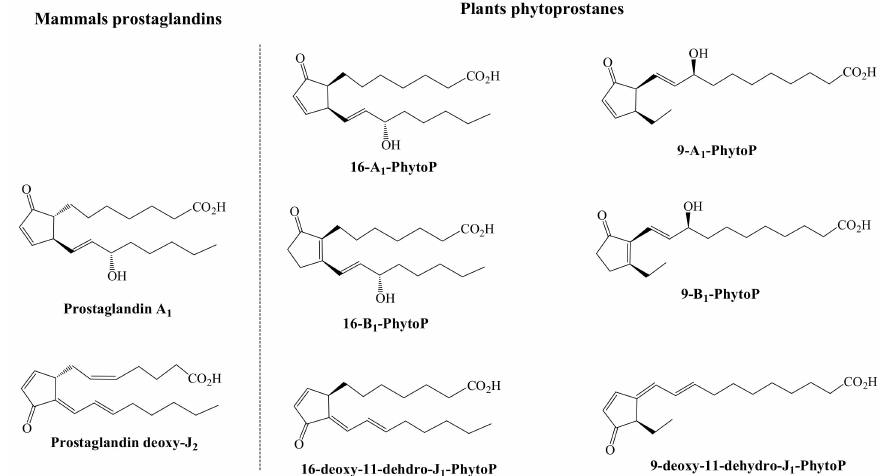
Figure 3. Chemical structure of the prostaglandin A 1 and deoxy-J 2 and the phytoprostanes A 1 , B 1 , and deoxy-J 1 sharing the capacity to inhibit the NF-kB-mediated inflammatory